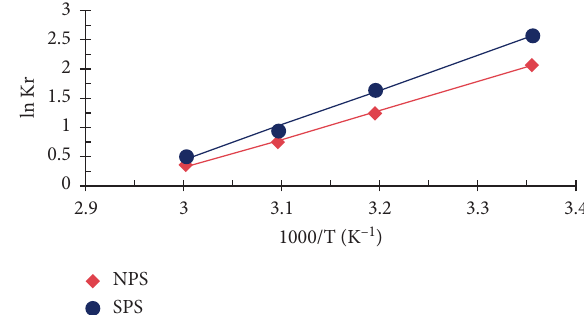
Figure 11: van’t Hoff plots for the FD removal by NPS and SPS (1g adsorbent dosage; 10mg/L concentration of FD; 50ml solution volume; 3h contact time)